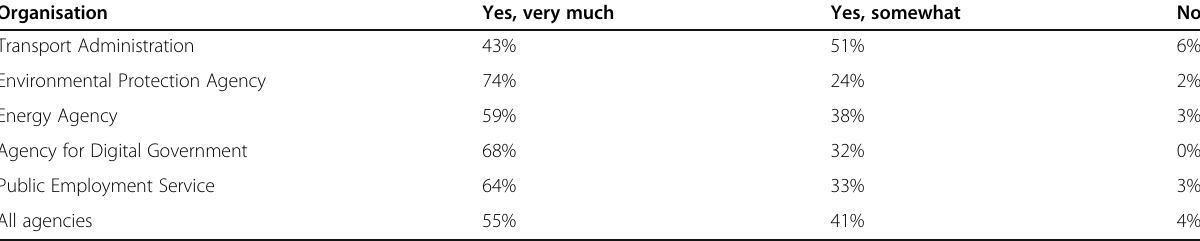
Table 3 Responses to the Question ‘ Has COVID-19 Affected Your Work Situation? ’